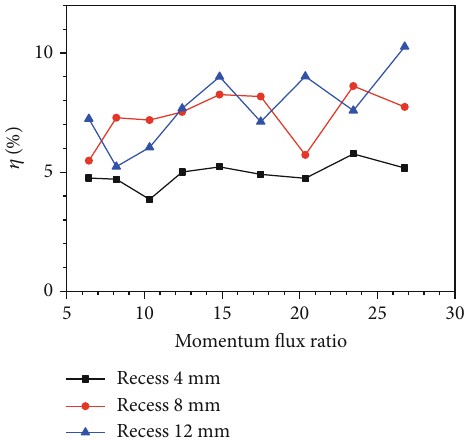
Figure 6: Damping factors in set no. 5 (test nos. 37-45) for various recess